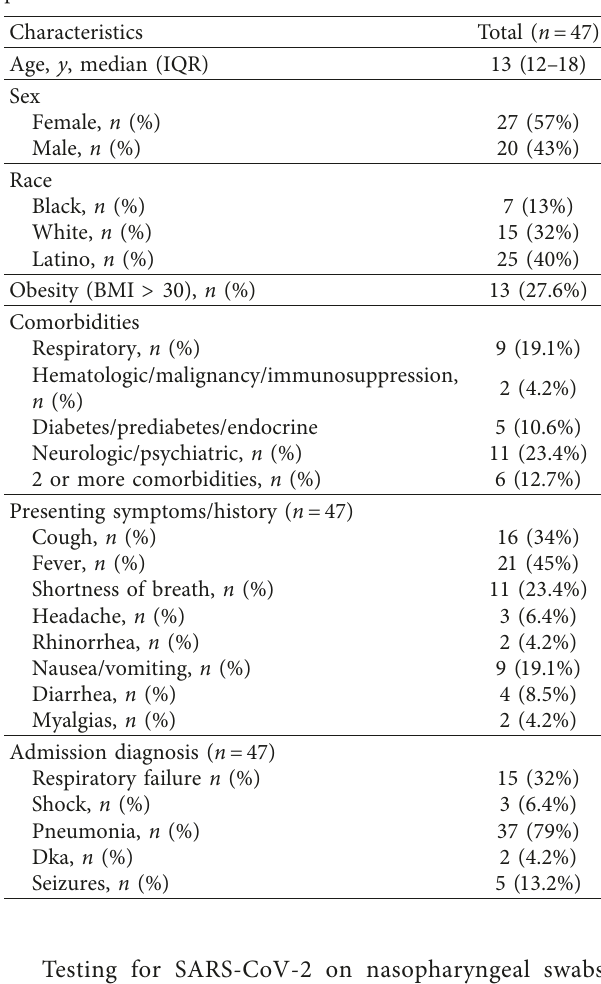
Table 1: Demographic and clinical characteristics of hospitalized